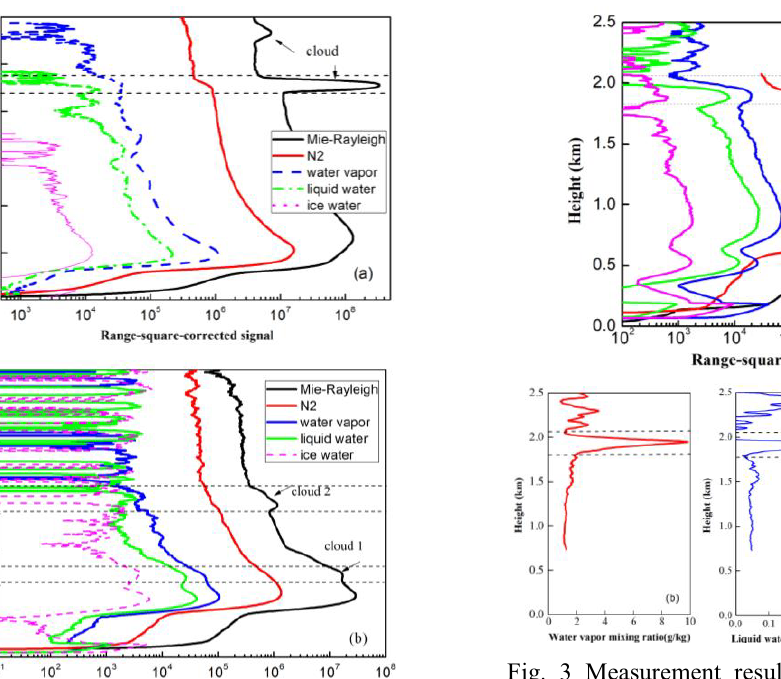
Fig. 3 Measurement results taken at 23:54 CST on December 24, 2018 under mild haze and cloud condition. (a)Range-square-corrected signal, (b)water vapor mixing ratio, (c)liquid water mixing ratio and (d)ice water mixing